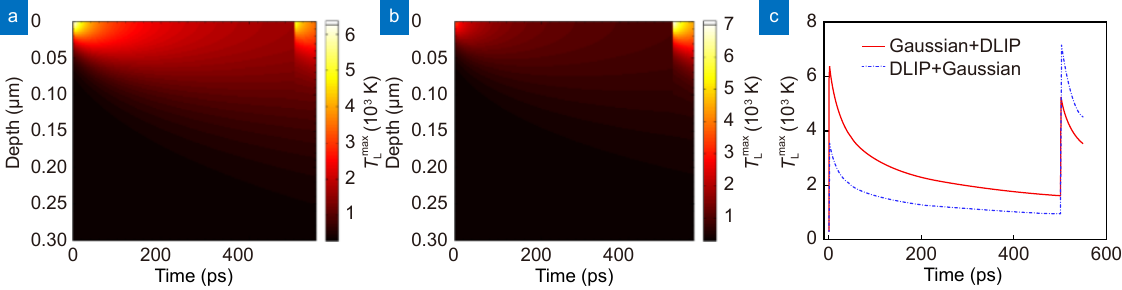
Fig. 2 | evolution at different depths for ( a ) G 1 = 1, G 2 = 0 and ( b ) G 1 = 0, P 2 =1, after irradiating a flat profile ( NP = 1) with E = 25 μJ, Δ τ = 500 ps. ( c ) on the sample surface as a function of time in the cases shown in (a) and